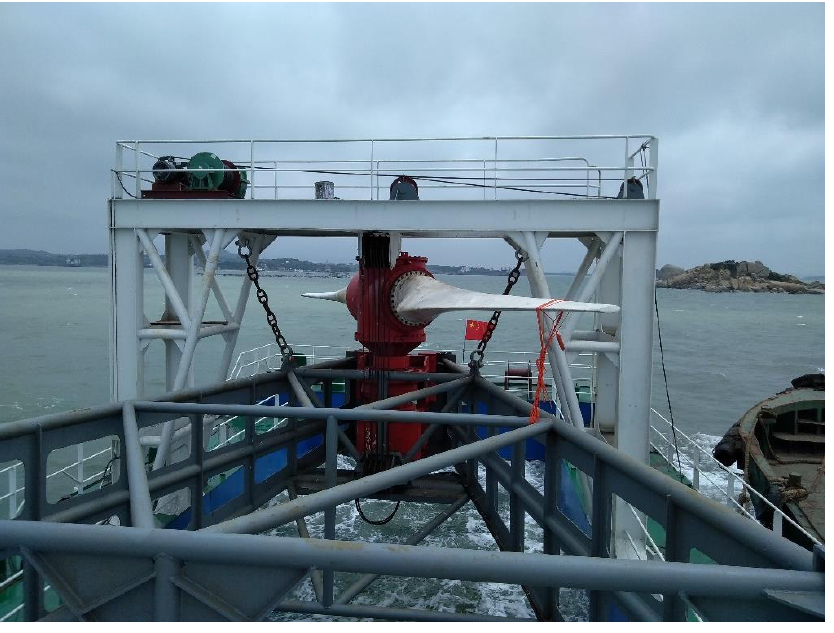
Figure 1. Prototype of the 120 kW HATCT.